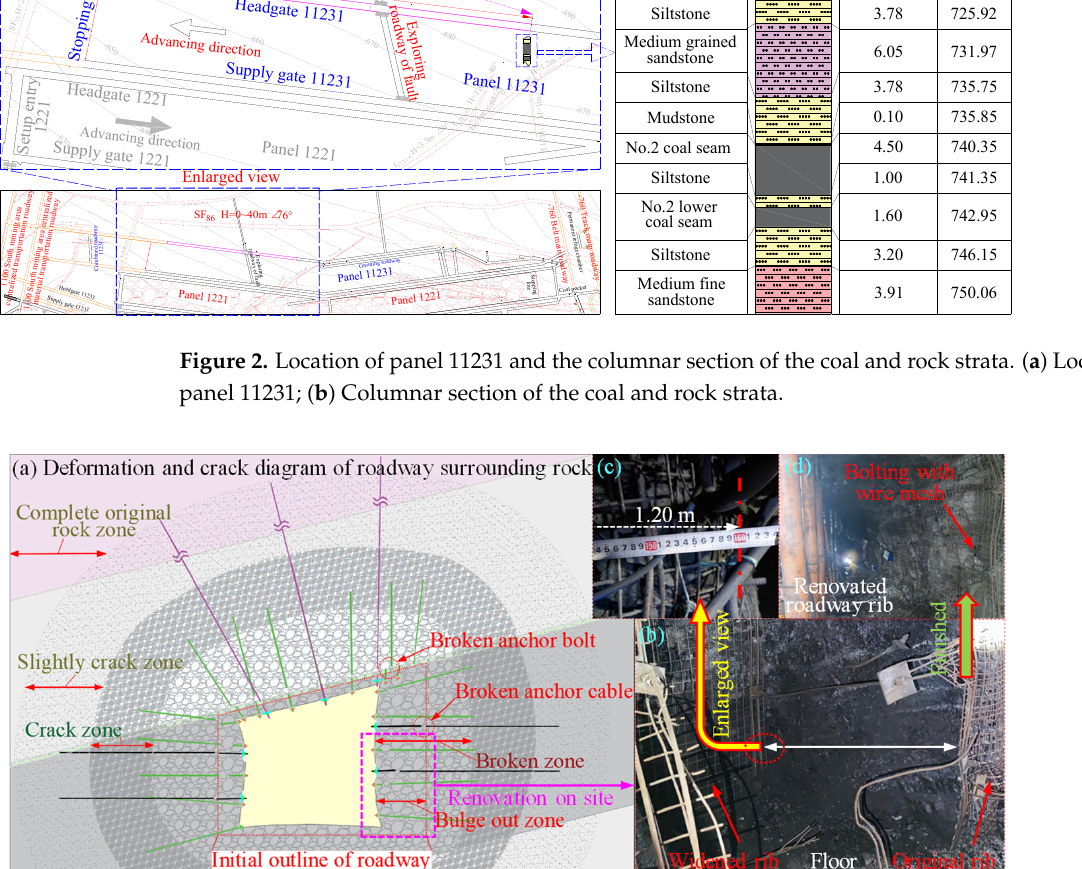
Figure 3. Renovation site of headgate 11231. ( a ) Deformation and crack diagram of roadway surrounding rock; ( b ) Roadway rib renovation site; ( c ) Repair depth of roadway rib; ( d ) The roadway rib has been renovated.